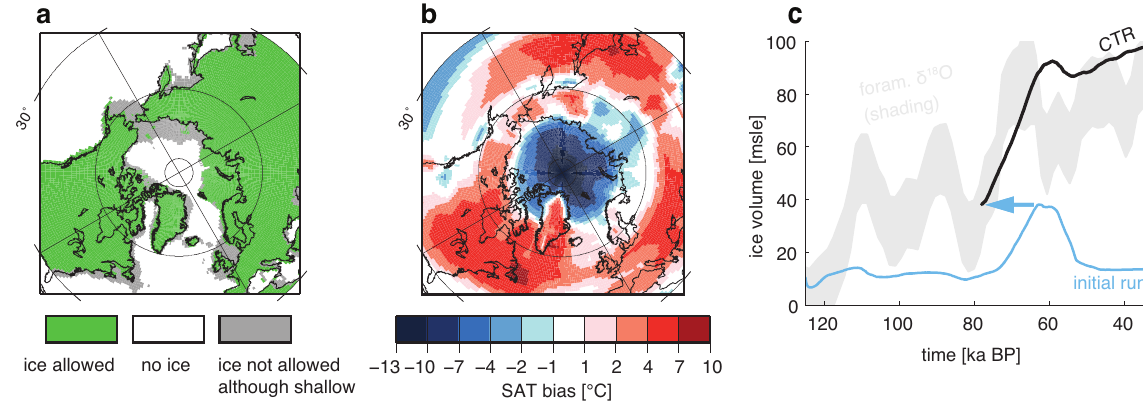
Fig. 1. Model setup and initialization. a, Prescribed domain in which ice sheet growth is possible (green area), compared to the ocean areas in which no ice sheet growth is possible, despite present-day water depths below 500 m (gray area, present-day topography interpolated from ETOPO5, 1988). b, LOVECLIM annual mean surface air temperature (SAT) bias computed for the period 1961 to 1990 relative to a climatology based on observations (Jones and Moberg, 2003). c, Simulated Northern Hemisphere (NH) ice sheet volume in meters sea level equivalent (msle) for the initial run starting in the Eemian (125 ka BP, blue curve), and the control run in the present study (CTR, black curve), compared to a reconstruction of global sea level based on benthic foraminifera oxygen isotope records (Waelbroeck et al., 2002, light gray shading indicates confidence interval +/-13 msle, which accounts for regression and dating uncertainties). Note that a sizeable inception in the initial run only sets in around 70 ka BP. The blue arrow illustrates the re-initialization, CTR is started at 78 ka BP with initial conditions from the initial run at 63 ka BP.